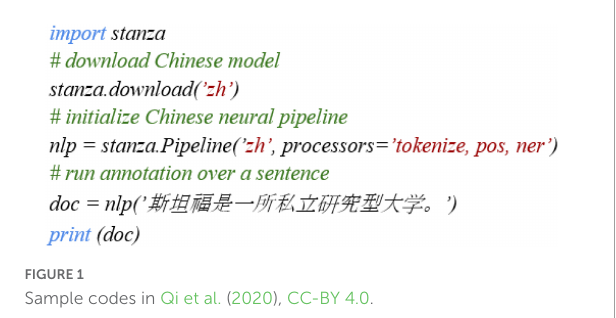
FIGURE1 Sample codes in Qi et al. (2020), CC-BY